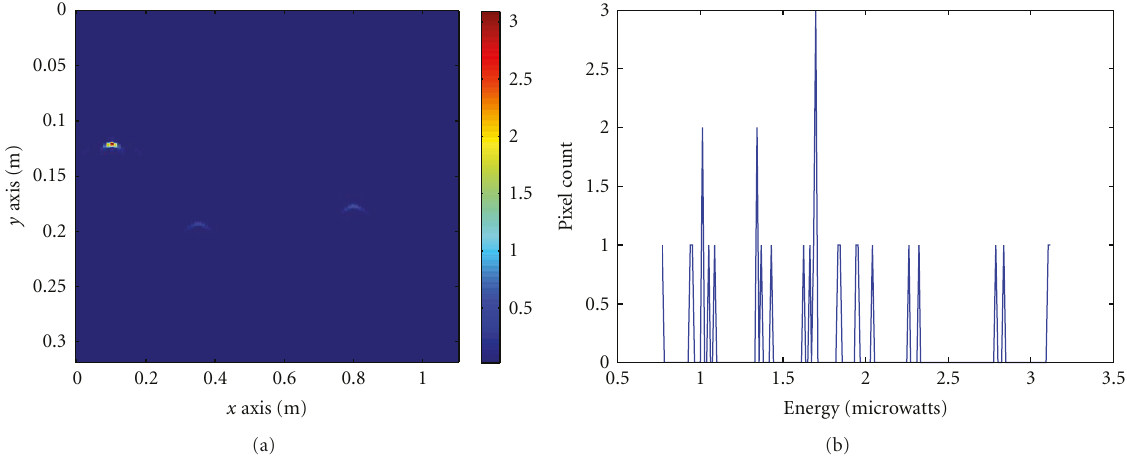
Figure 4: (a) Reconstructed data set using v = 0 . 8 v sim . (b) Image histogram.